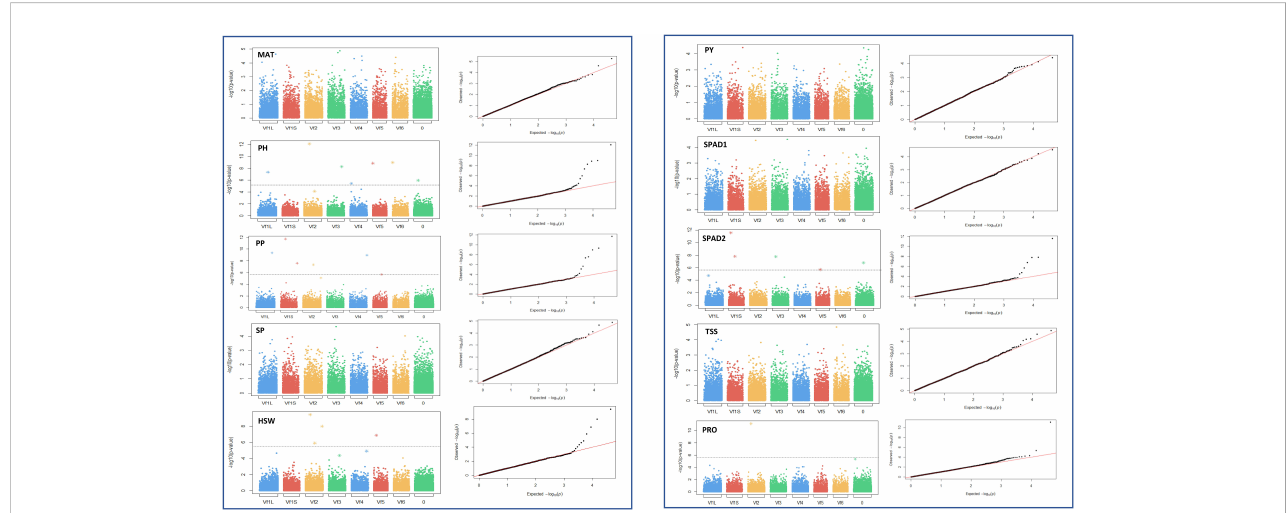
FIGURE 6 Manhattan plots and quantile-quantile (Q-Q) plots of the GWAS results for the 10 traits studied in drought stress conditions. MAT, maturity date; PH, plant height; PP, number of pods per plant; SP, number of seeds per plant; HSW, 100 seed weight; PY, plot yield; SPAD1 and SPAD2, chlorophyll content at the beginning of the stress treatment and about 4 weeks after onset of drought stress, respectively. PRO, free proline content; TSS, total content of soluble sugars. Bonferroni threshold (-log10 (p) > 5.87), is represented by a continuous grey line. X-axis represents the six faba bean chromosomes. The biggest metacentric chromosome I is divided in two corresponding to the large (L) and short (S) arms. Chromosome 0 stands for unknown